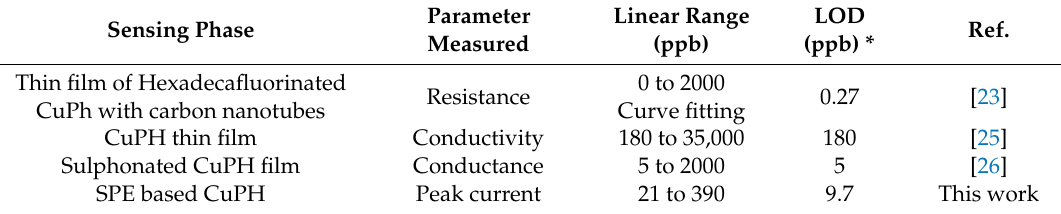
Table 2. Comparison chart of the analytical figure of merit among this work and the state of the art found in literature with works employing copper phthalocyanines as the sensing phase for chlorine detection. Sensing